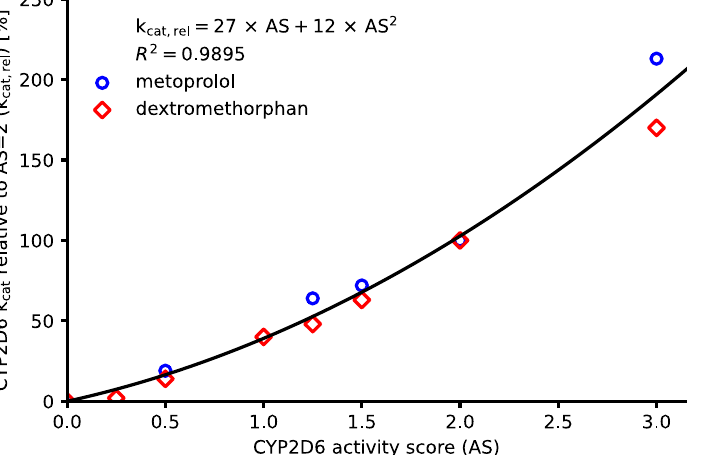
Figure 4. OLS regression of CYP2D6 k cat, rel values for the published DGI models of metoprolol and dextromethorphan [15,17]. The solid line represents the regression curve (degree = 2, intercept = 0), and symbols represent k cat, rel values for the different activity scores. AS: activity score, k cat, rel : k cat relative to AS = 2, and R 2 : coefficient of determination.